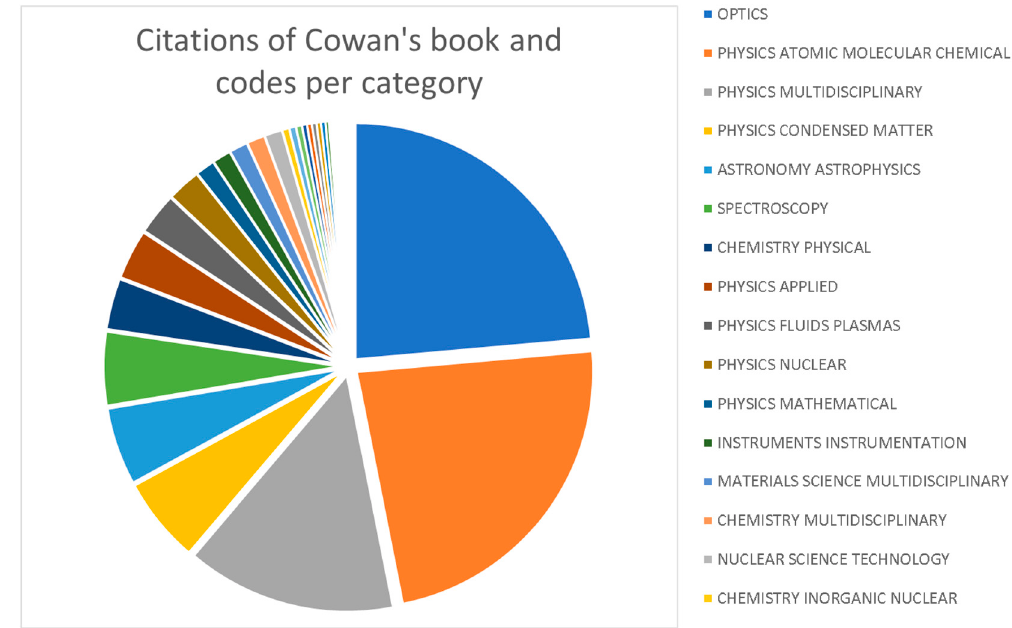
Figure 2. Distribution of 5026 citations to Cowan’s book [1] and the computer codes based on it, per research category (per Cited Reference Search of Web of Science [6]).